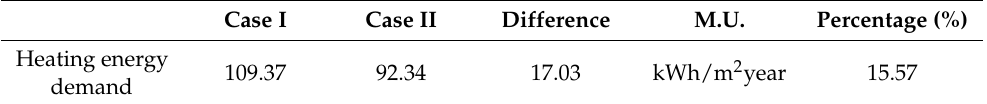
Table 6. Results for the dynamic method.